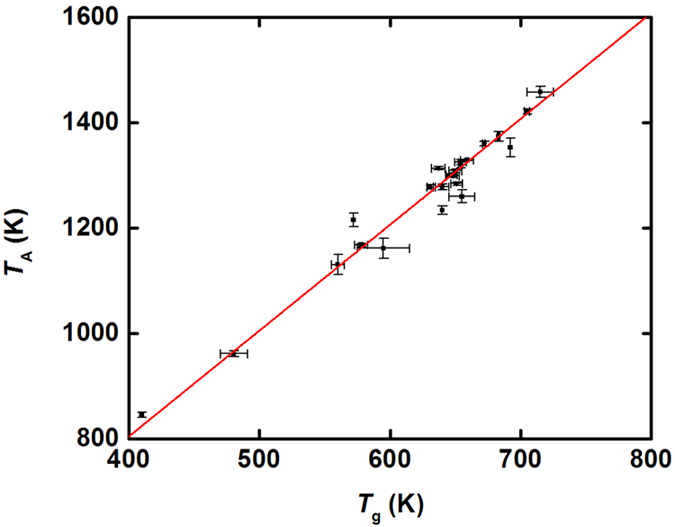
Comparison between the experimentally measured glass transition temperature, Tg, and TA from the fits to the high temperature viscosity data.The solid line is a fit to the data, giving TA = (2.02 ± 0.015)Tg. Error bars are one s.d.